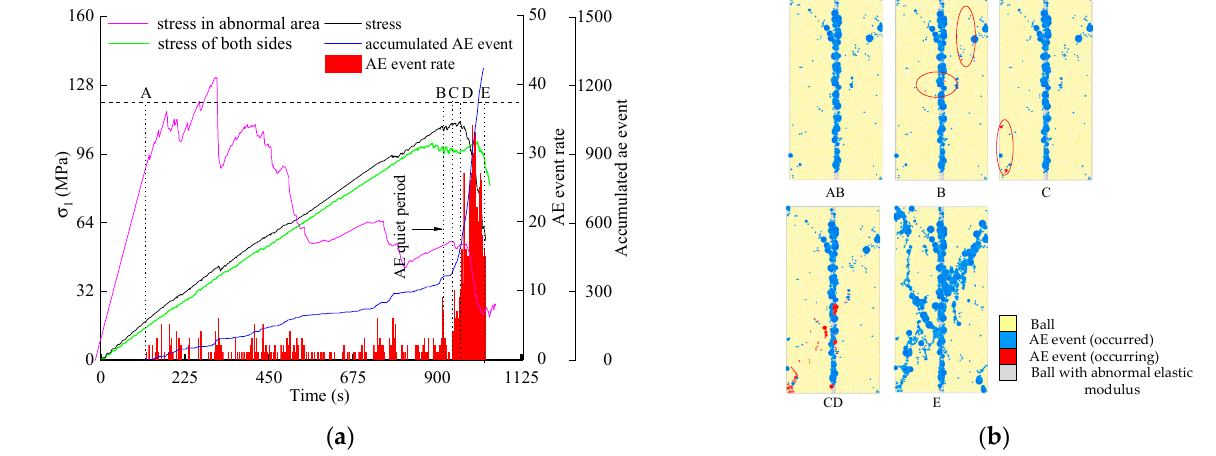
Figure 9. Numerical simulation results. ( a ) Stress and AE events of specimens with abnormal elastic modulus of 120 GPa; ( b ) AE events distribution at different stages of the specimen.